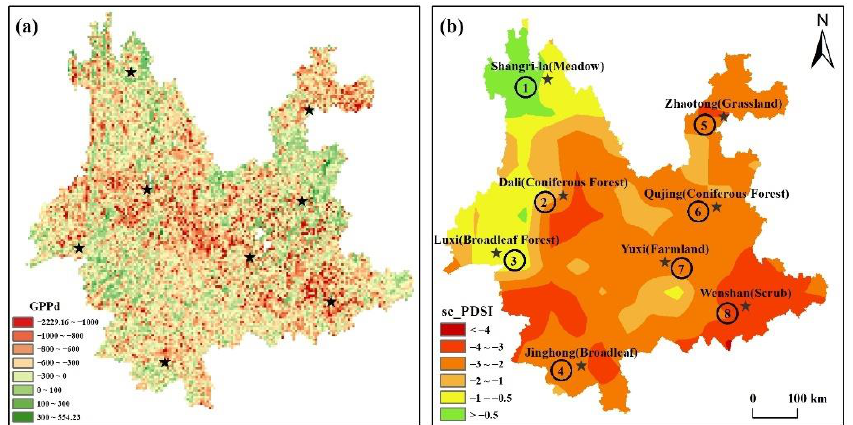
Figure 14. The total value of GPPd and the mean value of sc_PDSI in all months, 2009-06 – 2011-06. ( a ) total value of GPPd; ( b ) mean value of